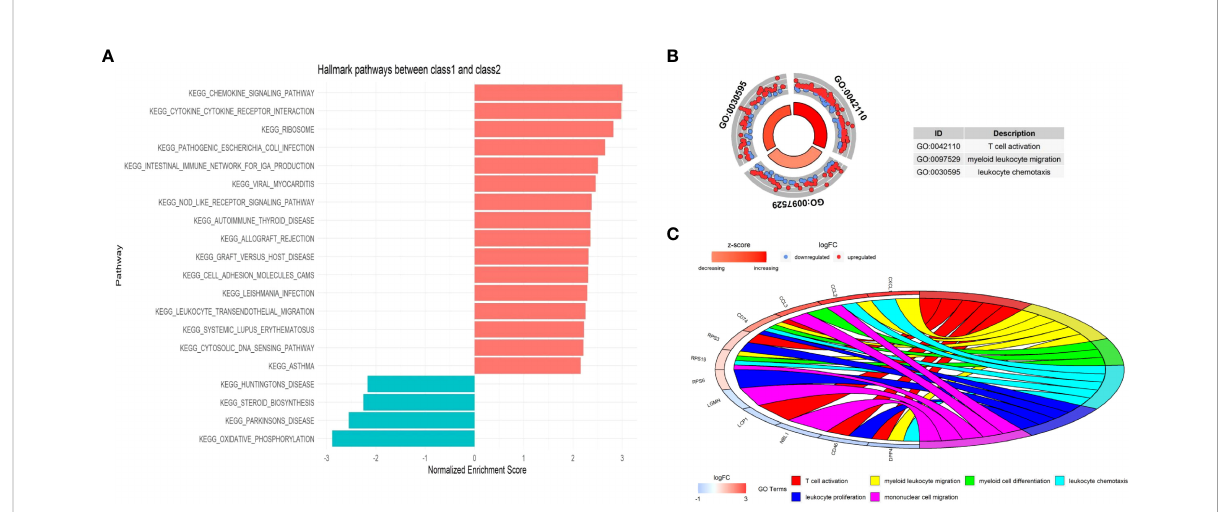
FIGURE 13 The functional enrichment between the two Classes at single-cell level. (A) Immune-related pathways were enriched by Gene Set Enrichment Analysis (GSEA). (B) Circle plot presents GO Biological Processes. (C) Chord plot presents GO Biological Processes and involved genes.